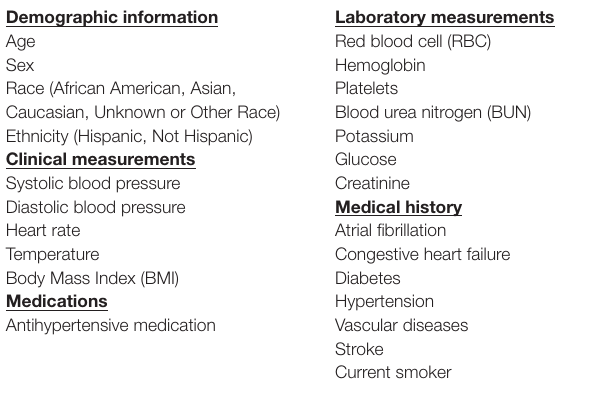
TABLE 2 | Features used in the